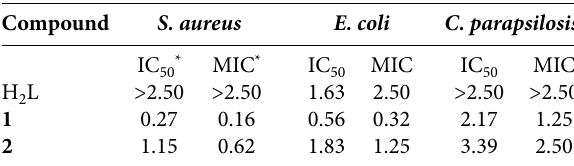
Table 3. Antibacterial property of the Schiff base and the complexes